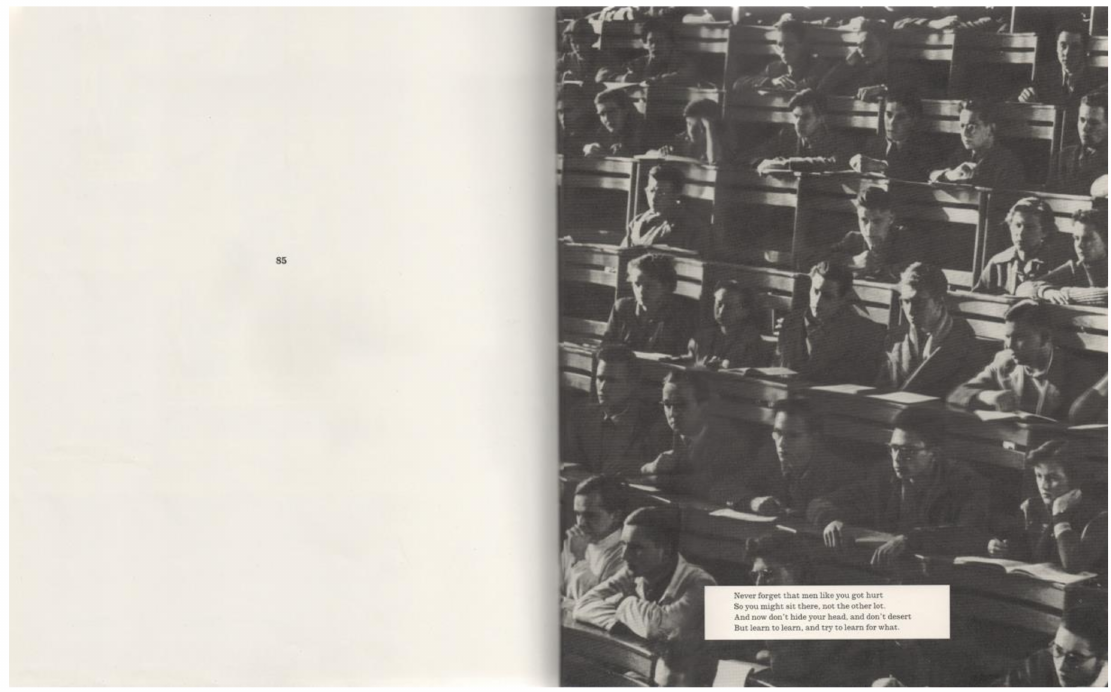
Figure 3. Brecht. 1998. War Primer . London: Libris. Plate